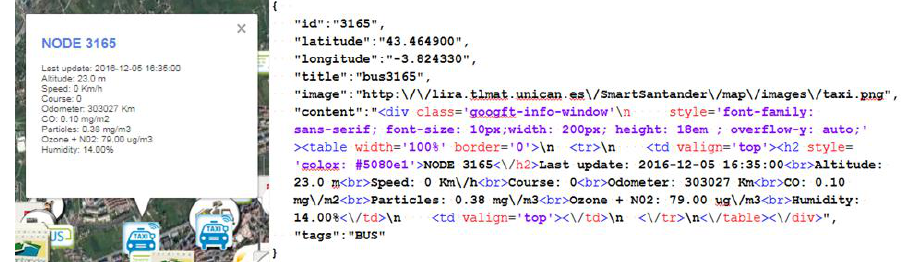
Figure 6. SmartSantander data example and access interface.